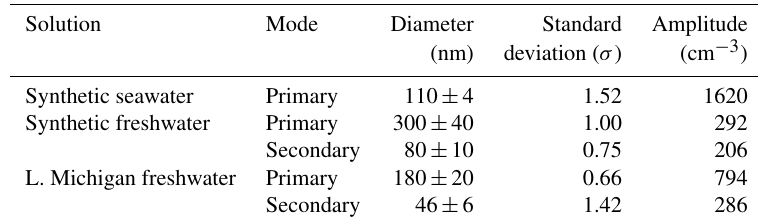
Table 1. Aerosol size distribution characteristics obtained from lognormal fitting for LSA generated from synthetic seawater, synthetic freshwater, and Lake Michigan freshwater.